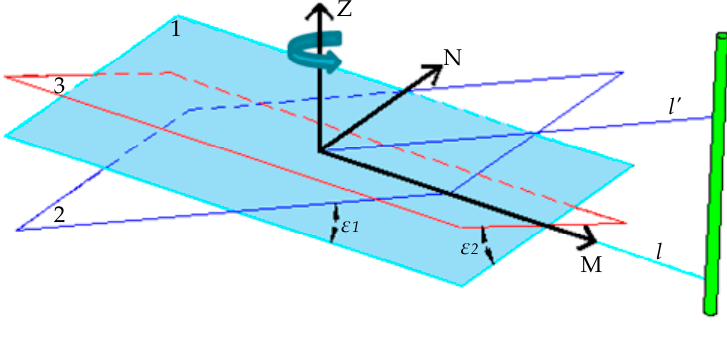
Figure 5. Attitude compensation of the robot.